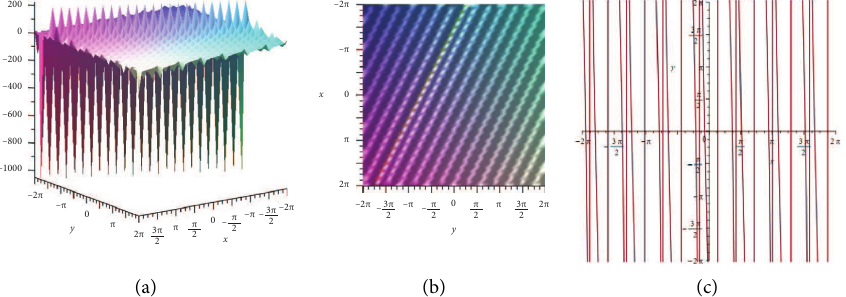
� 2 , C � 2 , and D � 3 at time t � 1. 0